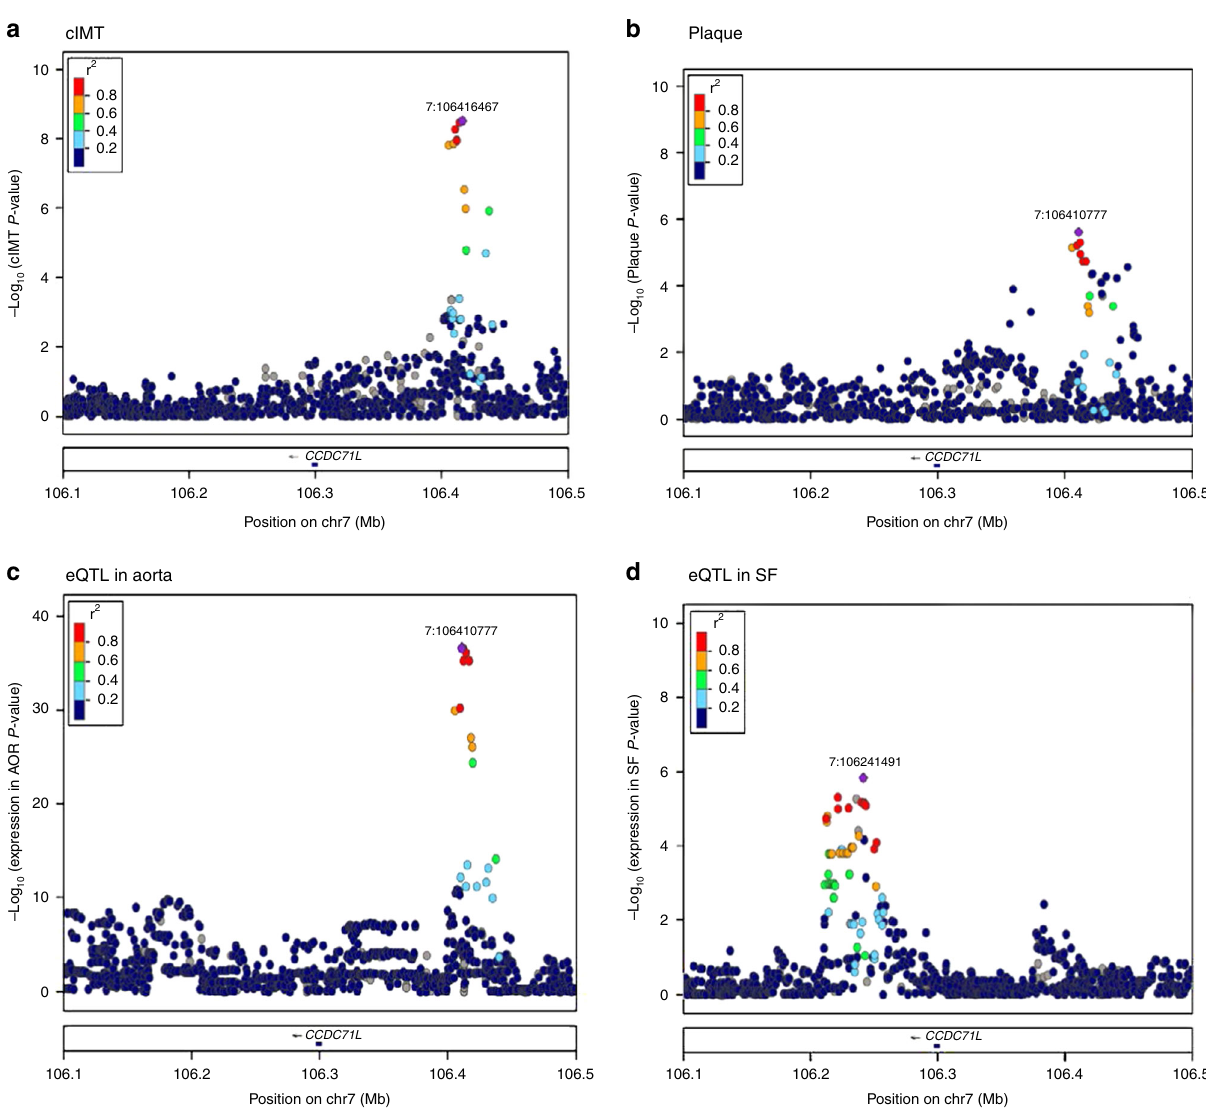
Fig. 3 Association results at the CCDC71L locus (chromosome 7), showing a high posterior probability of a shared variant for cIMT and carotid plaque in AOR and MAM eQTLs. − log10( p ) SNP association p -values for cIMT (plot A) and carotid plaque (plot B), and eQTL in AOR (plot C) and eQTL in SF (plot D). Association results in SF tissue have a low probability of a shared signal with cIMT and carotid plaque, possibly indicating a different mechanism in this tissue. eQTLs in MAM are identical to AOR and not shown. The p -values were calculated by fi tting a linear regression model with cIMT or plaque as dependent variable and imputed SNPs as independent variables. Each dot is an SNP and the color indicates linkage disequilibrium ( r 2 ) with the best hit